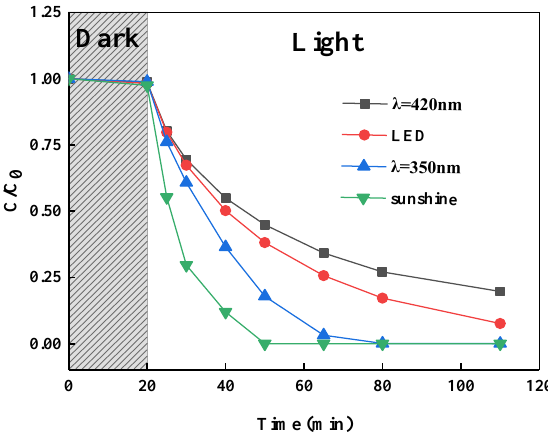
Figure 7. The relationship between C/C 0 and t of the effect of different light sources on the photocatalytic activity of 1% rGO – P25 photocatalyst (catalyst concentration 0.5 g/L, the initial concentration of BPA is 0.01 mol/mL, solution volume is 100 mL).